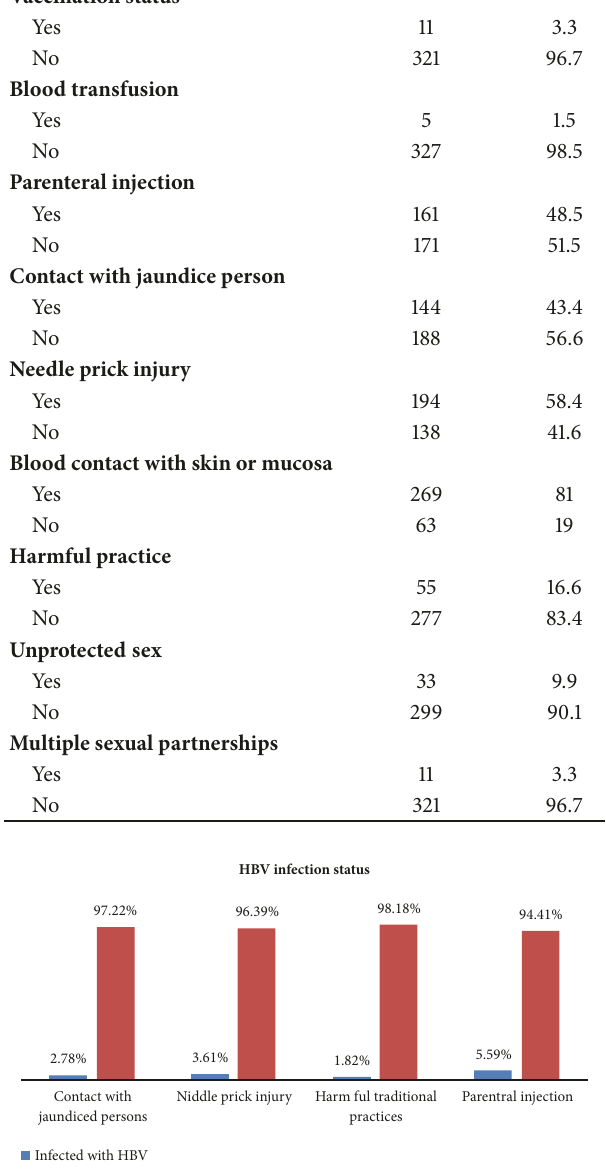
Figure 1: Prevalence of HBV infection with respect to different behavioral factors among HCWs at University of Gondar Hospital, Northwest Ethiopia,